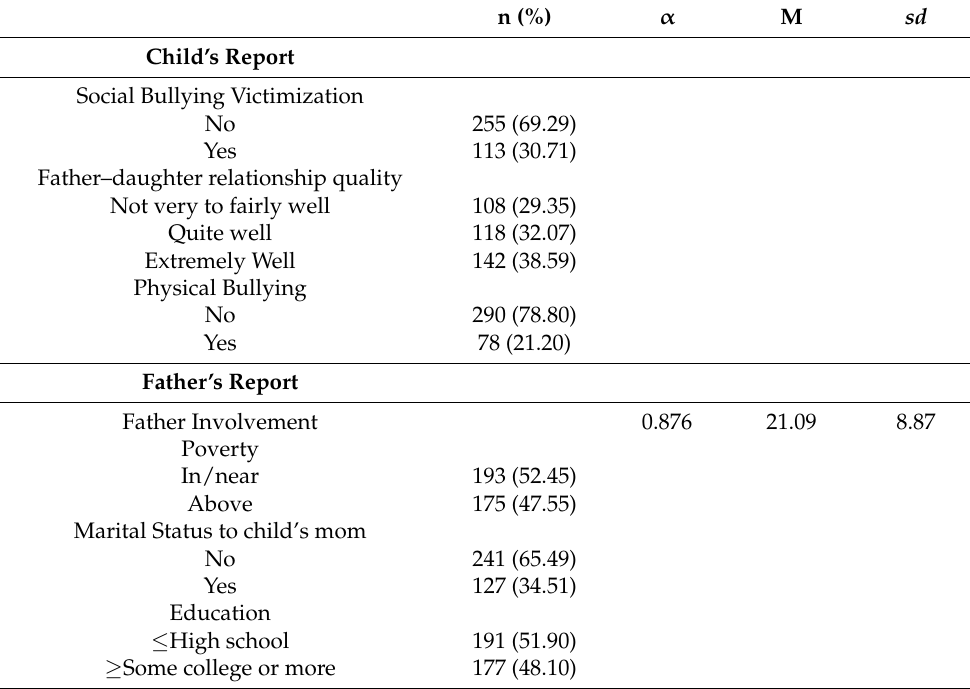
Table 1. Study Descriptive